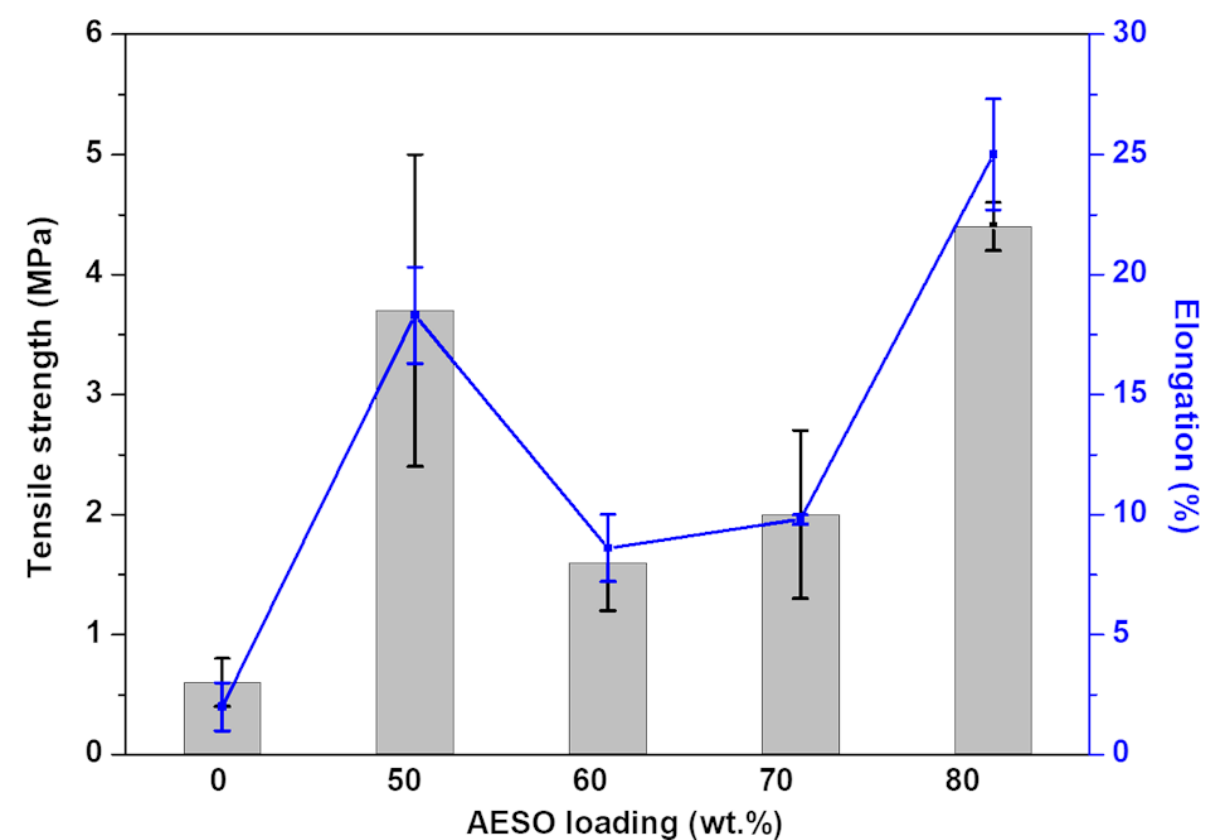
Figure 3. Variation of the tensile strength and elongation as a function of AESO loading. Statistical analysis for the elongation at break was performed using a one-way analysis of variance (ANOVA) with the level of significance set at probabilities of p < 0.05.